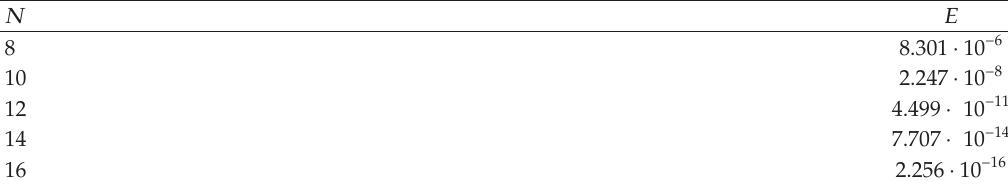
Table 3: Maximum pointwise error of u − u N